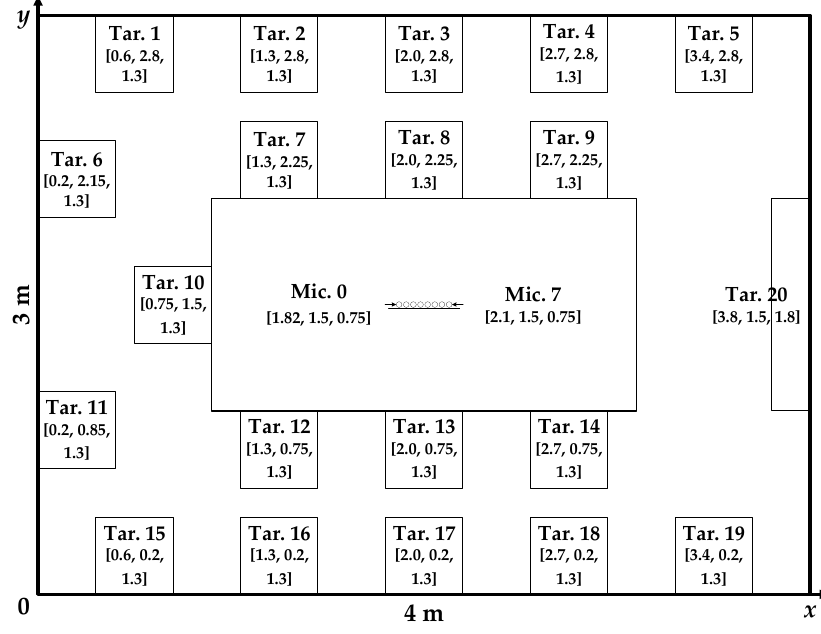
Figure 2. Simulation scene of a room considering 20 source locations and 8 microphones [34]. The speech signal is sampled at 16 kHz, a Hanning window with a length of 512 sam‑ ples has 50% overlap for analyzing the speech signal, and a 512‑point STFT is used for the windowed speech signal. The frame number for each batch in the MVDR beamforming is set to 70. The delay D that preserves the early reflections is set to 1, and the order L of the linear prediction filter is set to 10. The state transition matrix A ( l ) = α I , where α = 0.998. Similar to the default setting in [12], we let 10 log 10 ( φ e ) = − 4 dB and 10 log 10 ( φ e1 ) = − 4 dB in (56) and (57), whereas 10 log 10 (1 − β ) = − 25 dB in (58) and